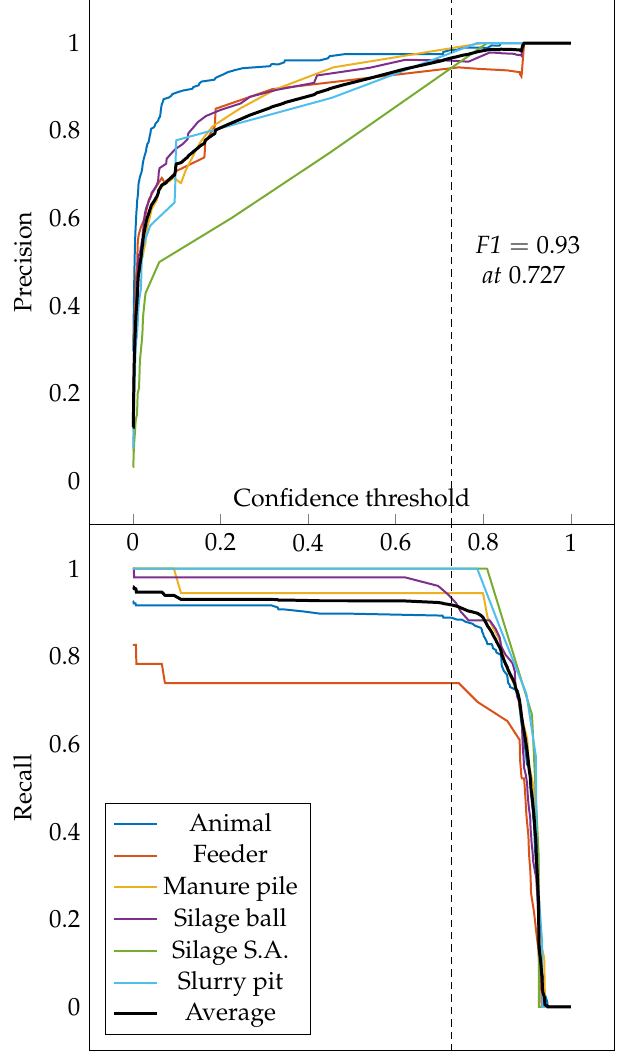
Figure 7. Evolution of Precision and Recall for different confidence